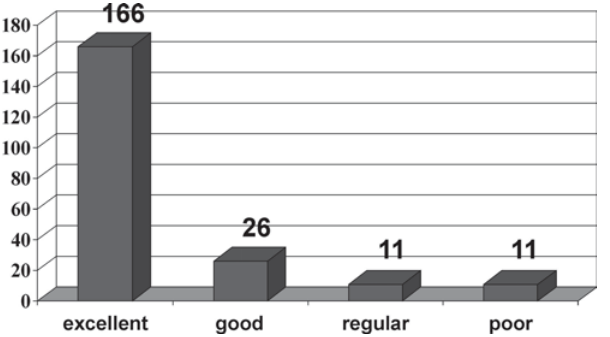
Figure 5 - Functional